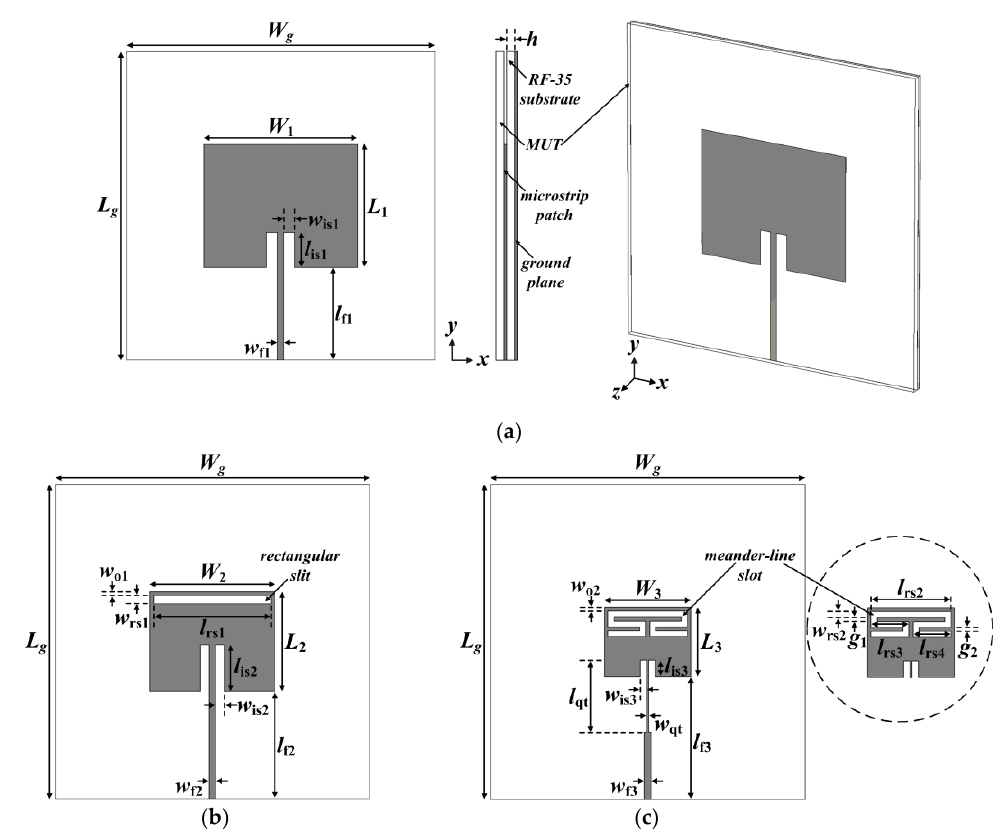
Figure 1. Geometries of the three microstrip patch sensor antennas (MPSAs): ( a ) conventional inset-fed rectangular MPSA; ( b ) rectangular slit (RS)-loaded MPSA; and ( c ) proposed meander-line slot (MLS)-loaded MPSA.